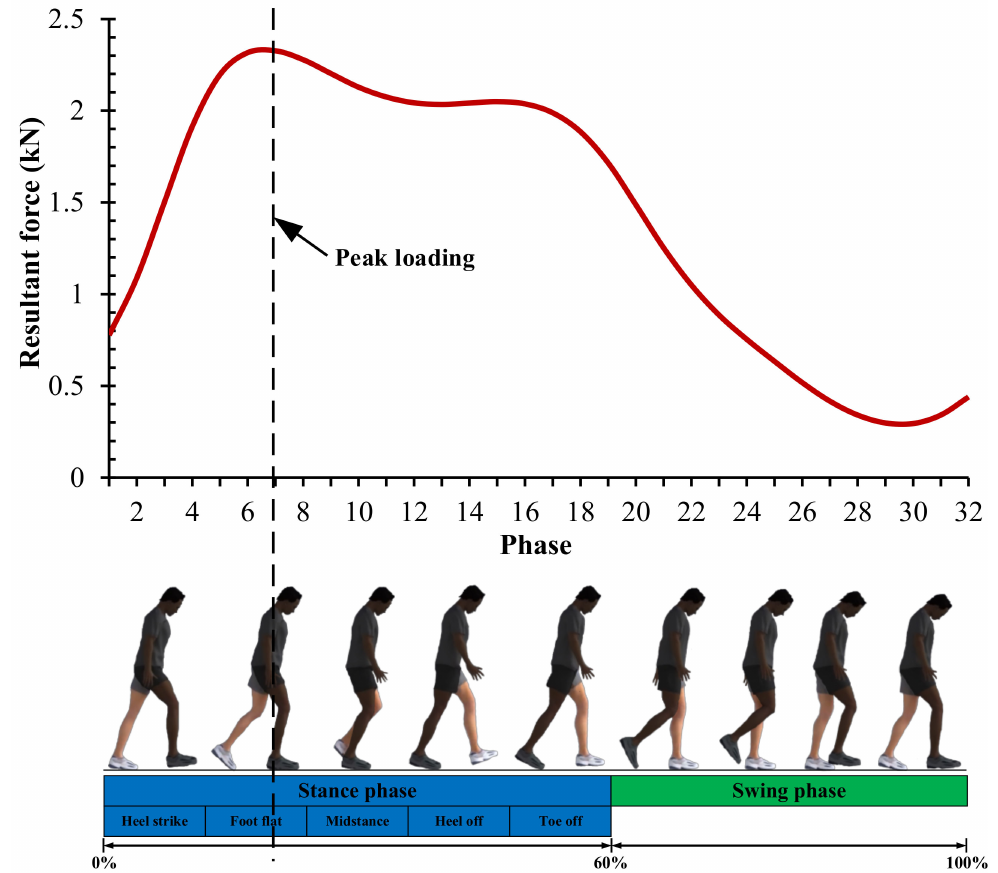
Figure 2. Gair loading based on normal walking condition